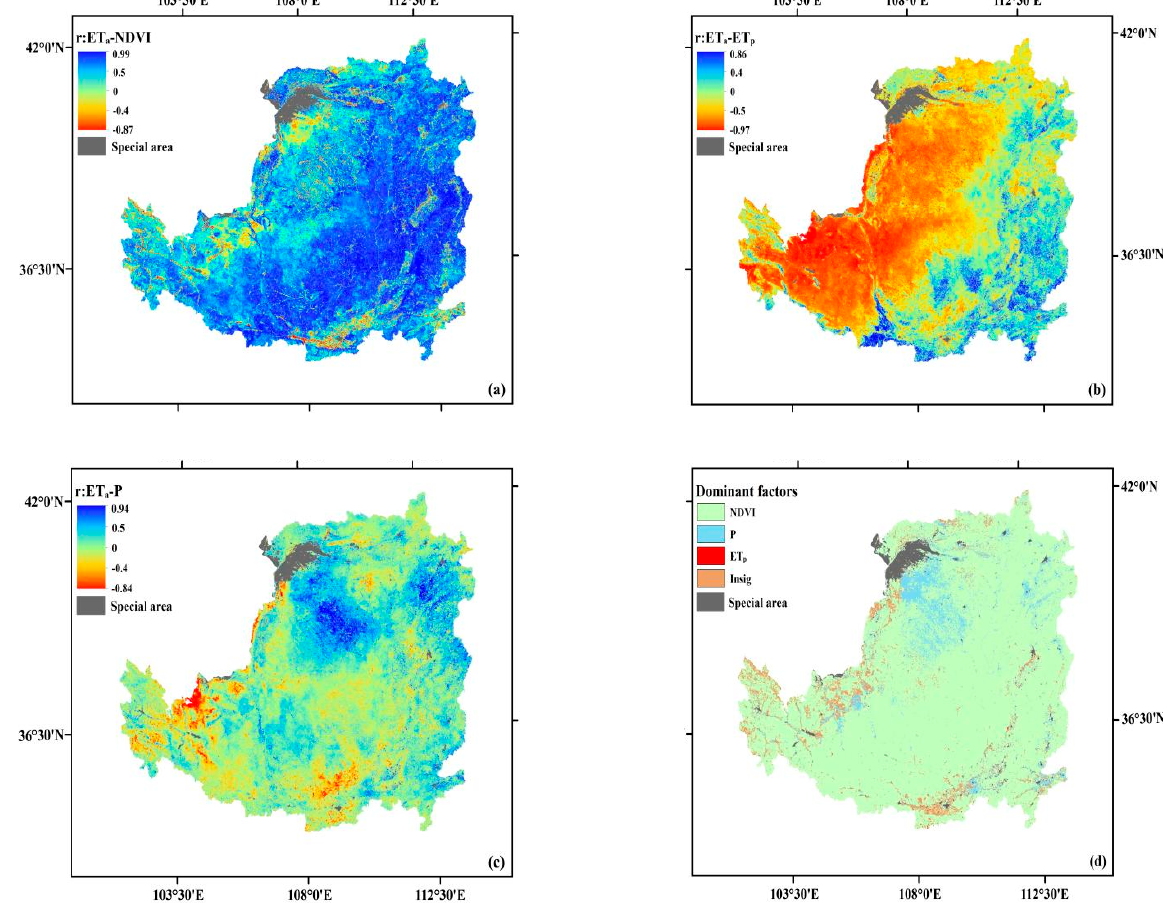
Figure 9. Spatial patterns of the partial correlation coefficient between annual ET a and NDVI ( a ), ET p ( b ), and Precipitation ( c ); and the dominant driving forces of the inter-annual variation of ET a ( d ) in the LP during 2000–2018.